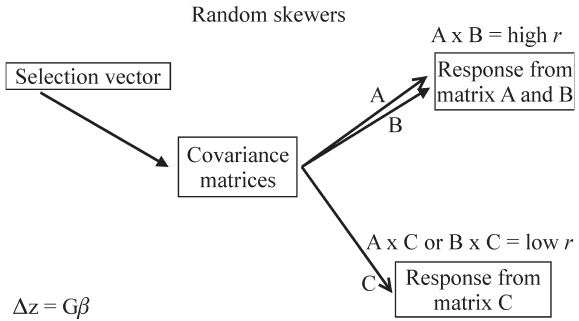
Figure 1 - Illustration of Random Skewers (RS) method for variance/ covariance matrix (G) comparison. Random selection vectors (ß) are ap- plied to matrices (A, B, C) using the multivariate evolution equation and the results (?z) compared using vector correlations. Matrices A and B are quite similar to each other and both very different from matrix